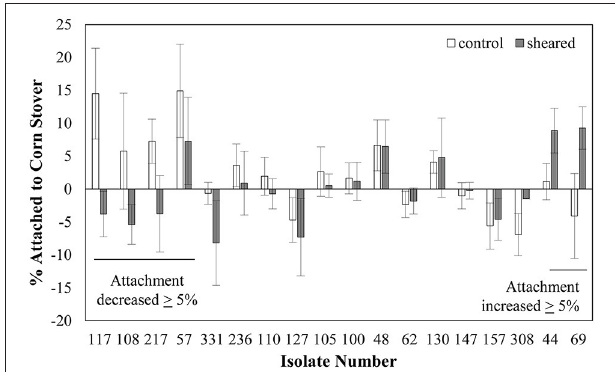
FIGURE 2 | Shearing impacts the attachment of some E. coli isolates to corn stover. Values are the average ± standard error of 3–6 replicates. Strains are ordered by the value of the change in attachment after shearing treatment.